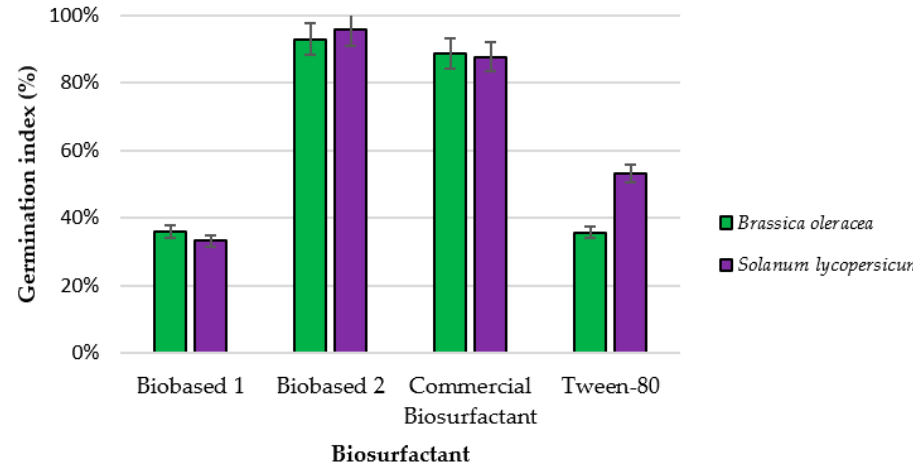
Figure 4. Germination index (%) of Brassica oleracea and Solanum lycopersicum seeds in the presence of the surfactants. Error bars represent the standard deviation of the results.